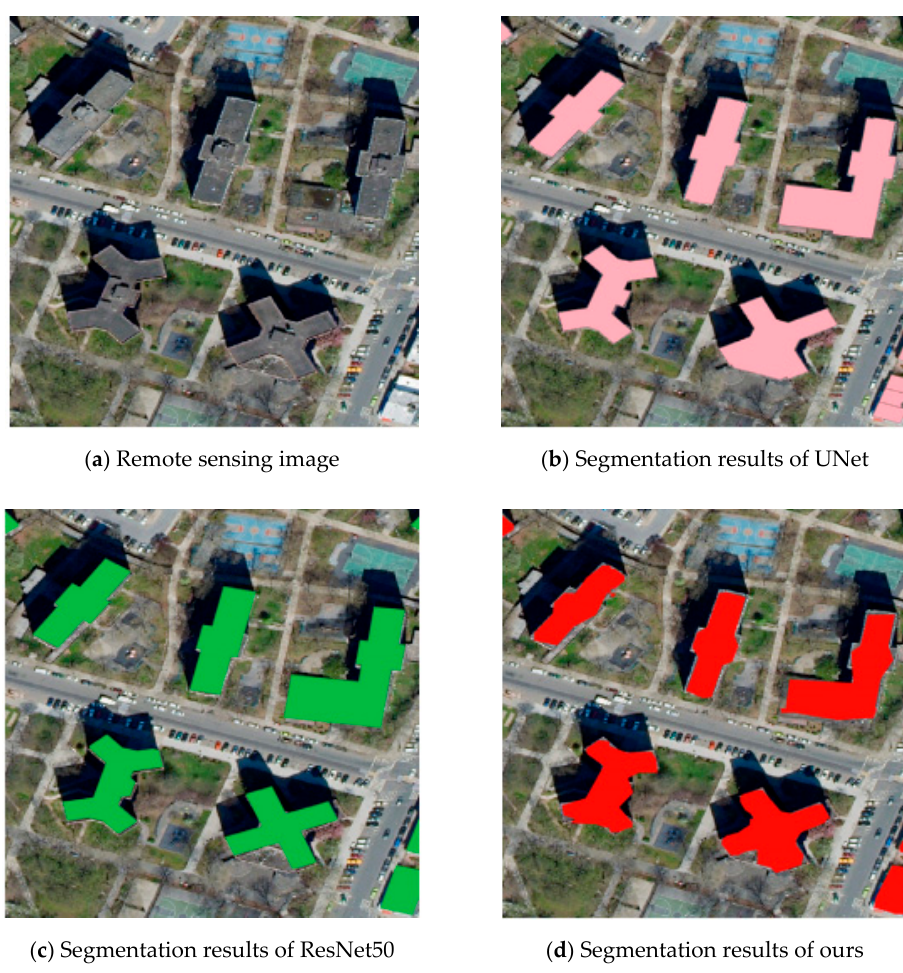
Figure 6. Representative evaluation of our approach and other competing approaches.